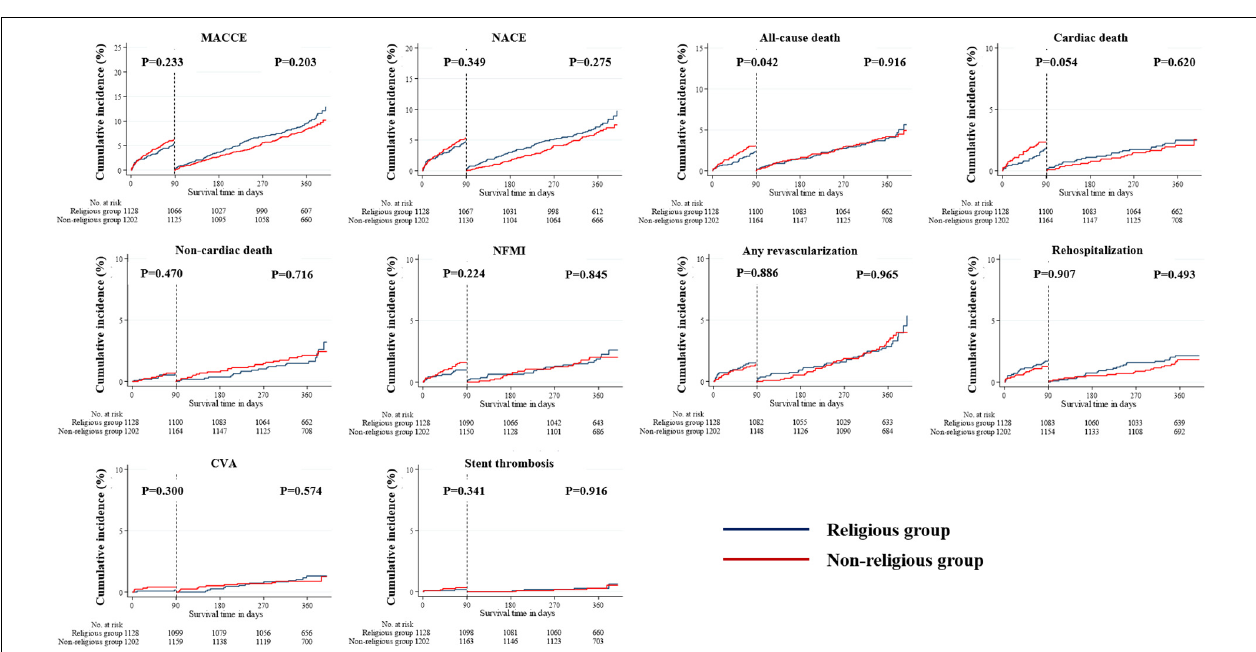
FIGURE 5 | Incidences of primary and secondary clinical outcomes in all patients after a 1-year follow-up (after IPTW-adjusted analysis). The figure shows the Kaplan–Meier curves for the cumulative event rates according to their religious faith. IPTW, inverse probability of treatment weighting.